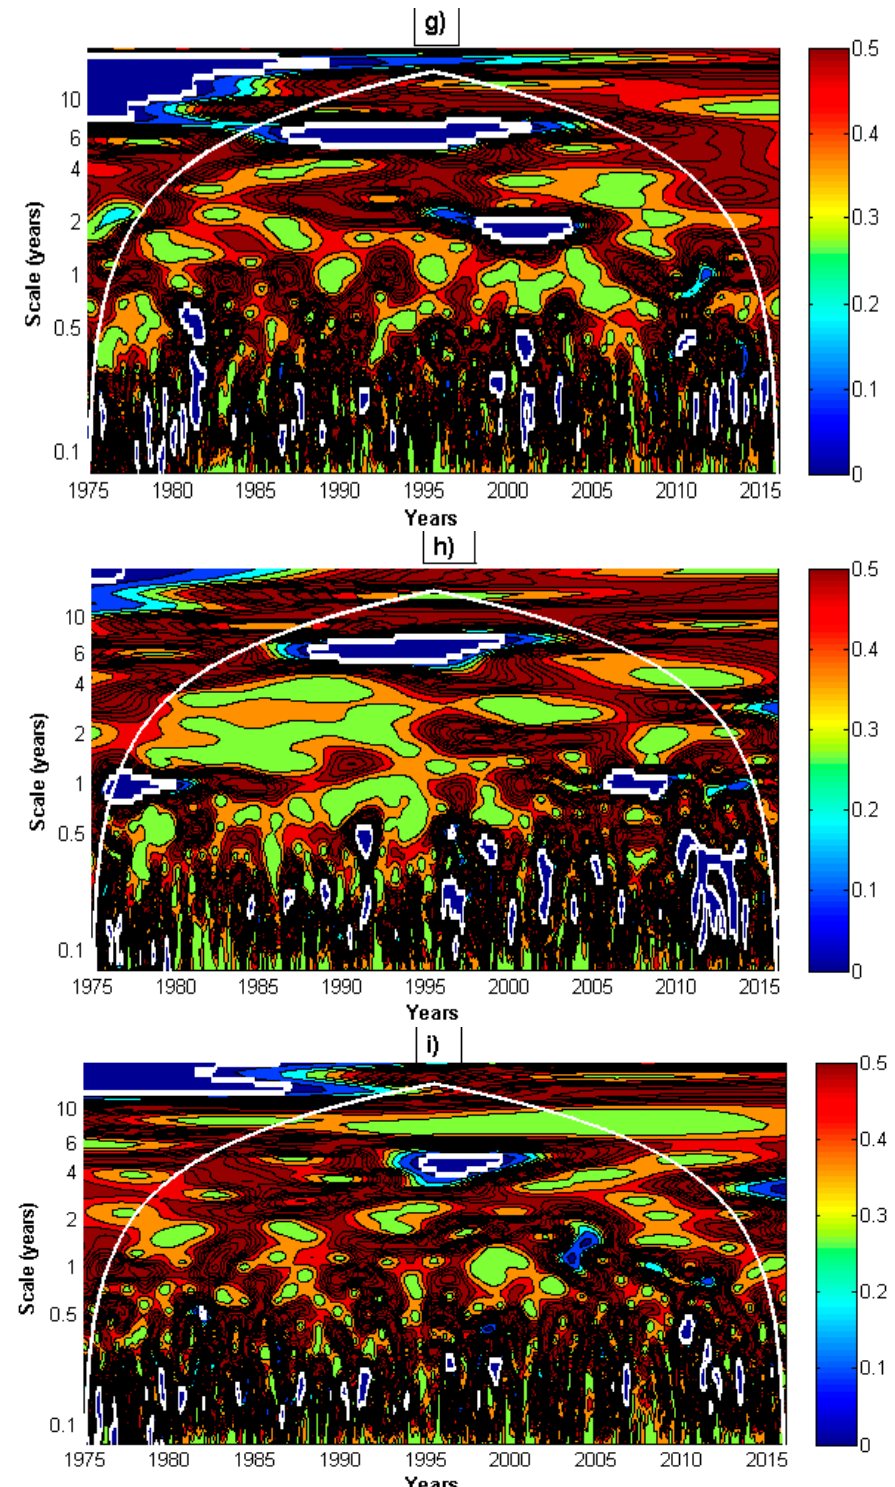
Figure 3. Wavelet power spectra (WPSs) for ( a ) discharge, ( b ) sodium, ( c ) sulfate and significance levels ( p values) of deviations from those WPS of WPS of the best fitted ARMA processes and of WPS of AR(1): Best ARMA significance levels of the deviation for ( d ) discharge, ( e ) sodium, ( f ) sulfate, AR(1) significance levels of the deviation for ( g ) discharge, ( h ) sodium, ( i ) sulfate. Broad white lines correspond to p = 0.05, and the areas inside these lines then contain the points (t,s) with significant differences to WPS of time series. The cone of influence (COI) appears as a thin white line.